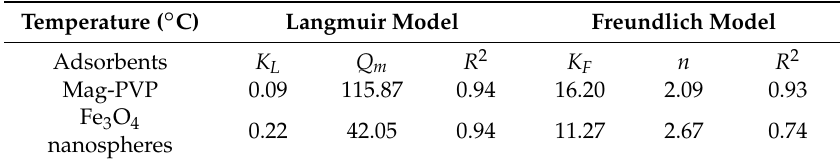
Figure 5. ( a ) Adsorption equilibrium for bisphenol A (BPA) on Fe 3 O 4 nanospheres and Mag-PVP and their model fitting by Langmuir and Freundlich isotherm models (adsorbent dosage = 0.2 g/L; agitation speed = 150 rpm; shaking time = 4 h; temperature = 20 °C ); ( b ) The effect of contact time on the adsorption of BPA by Mag-PVP (adsorbent dosage = 0.2 g/L; agitation speed = 150 rpm; temperature = 20 °C ; BPA concentration = 10 mg/L). Error bars represent standard deviation values from three replicates. Q e = equilibrium adsorption capacity. C e = equilibrium concentration of BPA. Table 1. Parameters of the Langmuir and Freundlich models for the adsorption of BPA on Mag-PVP and Fe 3 O 4 nanospheres at 20 ◦ C. K L = Langmuir binding constant. Q m = maximum adsorption capacity of the polymers. K F = Freundlich constant. n = an indication of the favorableness of the adsorbent/adsorbate